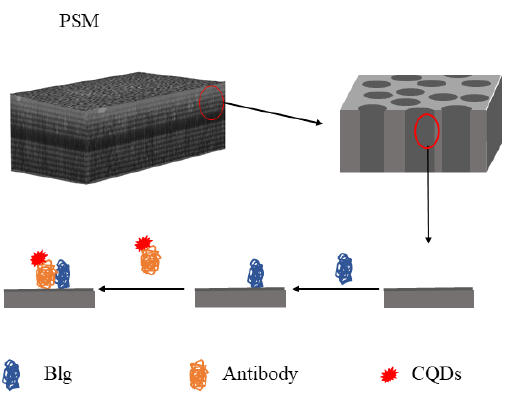
Figure 5. CQDs labeling of CQD-linked β -LG antibody and the process of immune response.